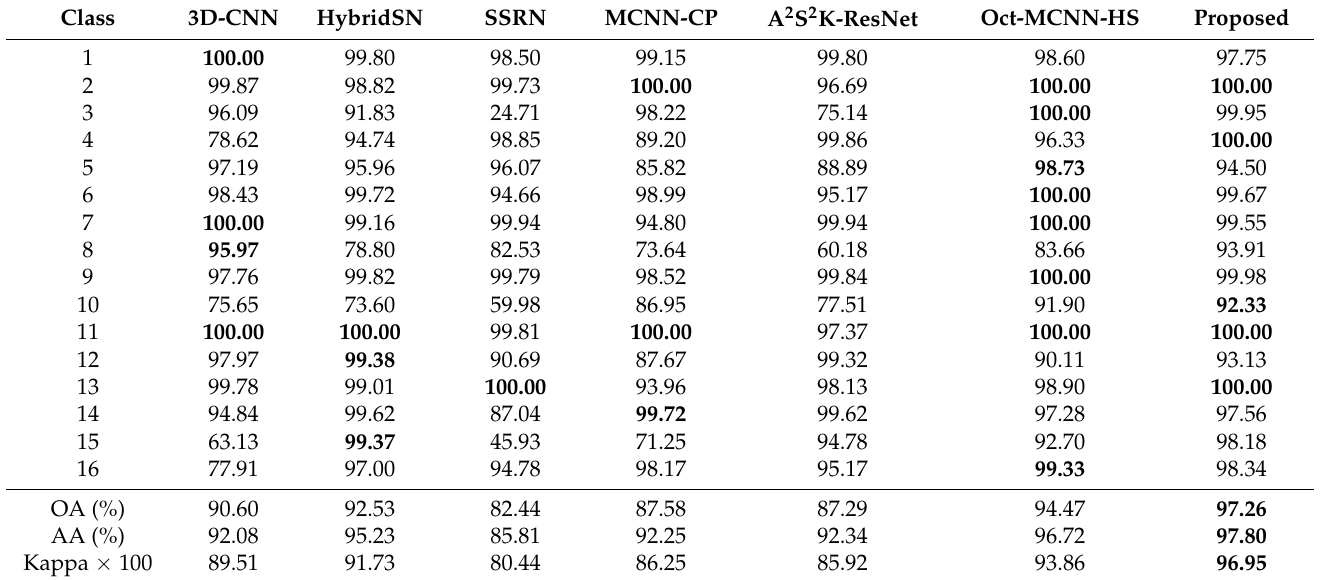
Table 9. The classification accuracy of different methods on the SA